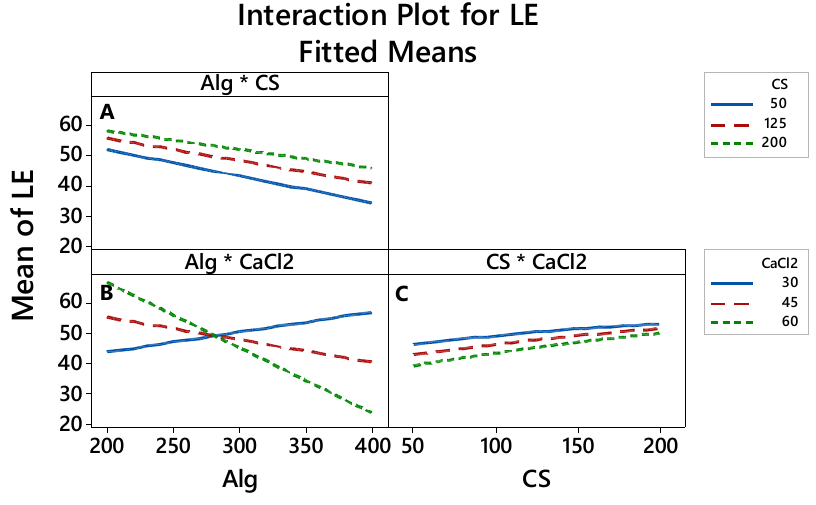
Figure 6. Interaction effects of factors on the loadingefficiency.